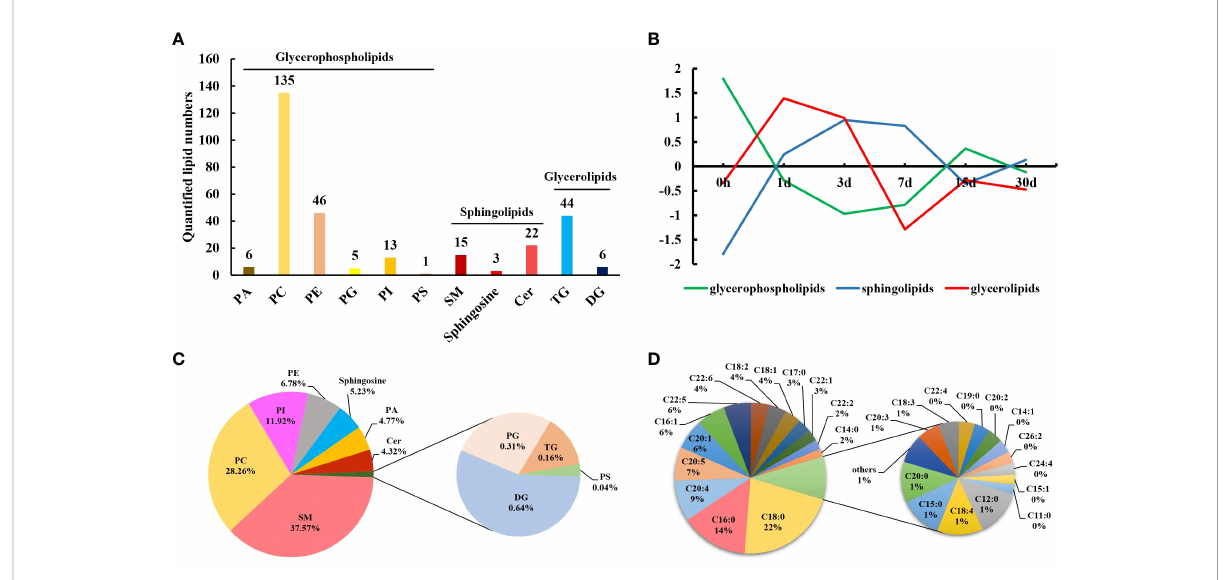
FIGURE 1 (A) Lipids identi fi ed in pearl oyster P. f. martensii after transplantation. (B) Changing trends of clustered lipid classes throughout different transplantation periods. (C) Relative proportions of different lipid subclasses in transplanted pearl oyster. (D) Mass percentages of membrane- esteri fi ed fatty acids in GP identi fi ed in transplanted pearl